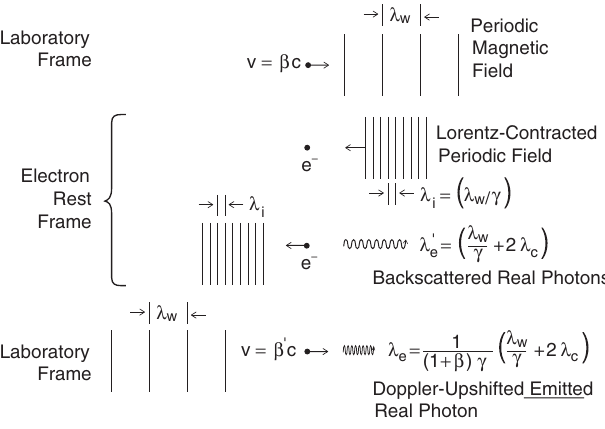
FIG. 1. Wavelength of magnetic bremsstrahlung emitted in a periodic magnetic field. In the electron rest frame, a stationary transverse magnetic field with period λ becomes indistinguish- w = γ . Photons able from a traveling plane wave with a period λ w backscattered from this Lorentz-contracted field are shifted to a wavelength longer by 2 λ by the Compton effect. The back- c scattered rest frame photons are Doppler upshifted by a factor of ð 1 þ β Þ γ to appear in the laboratory frame as real emitted photons with wavelength λ e